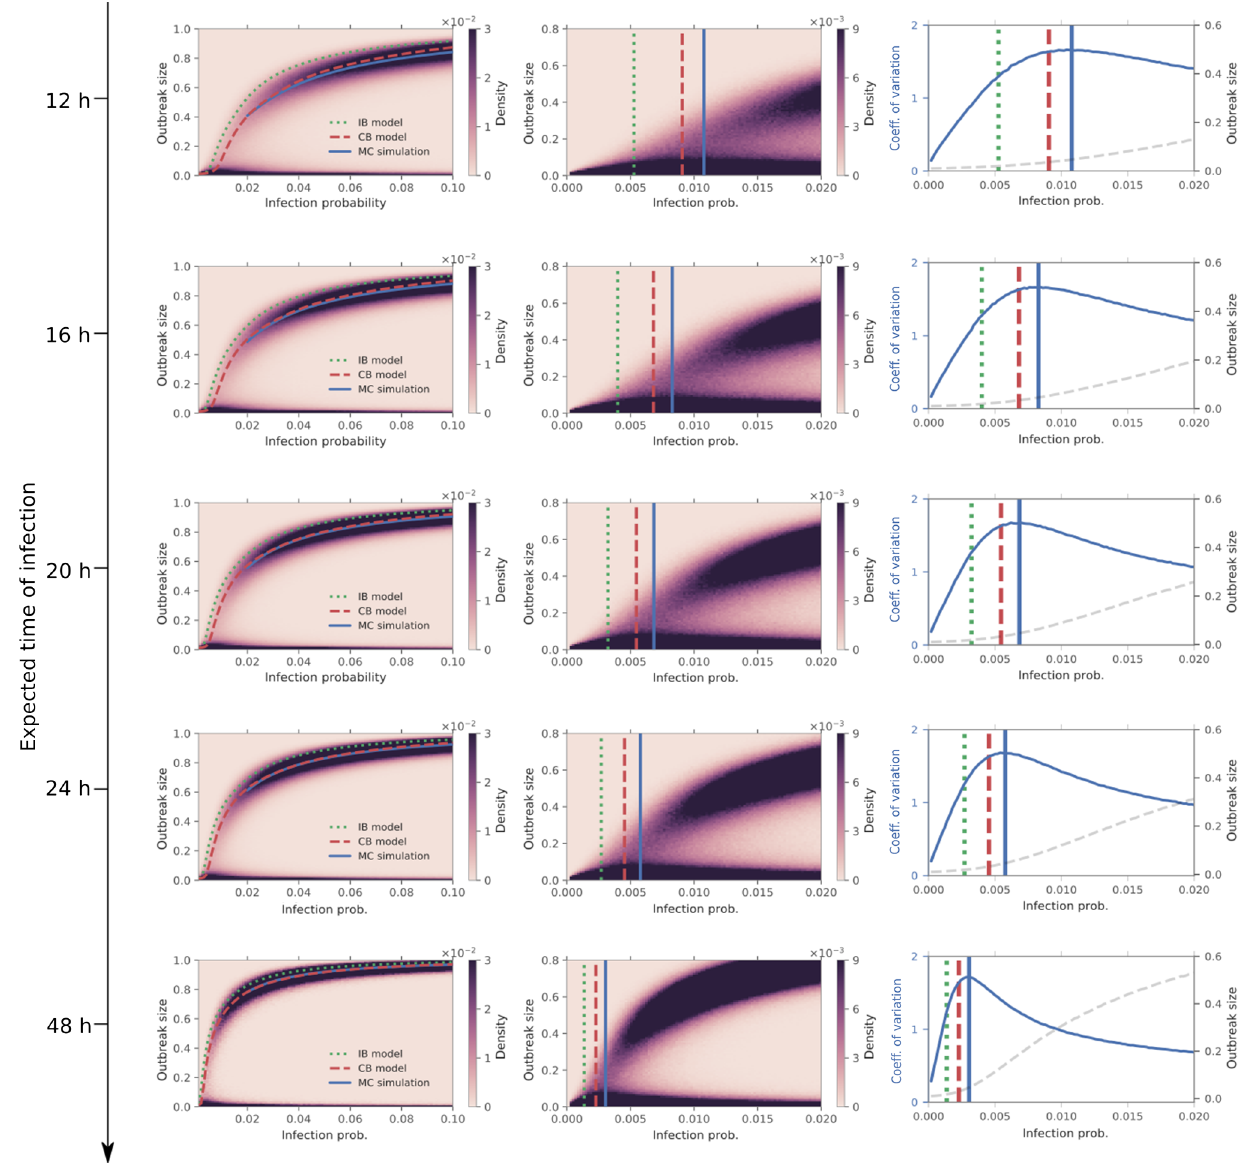
FIG. 18. Comparison between MC simulations and the mean-field models for different values of μ . Every row assumes a fixed recovery probability μ with decreasing values from top to bottom: μ ¼ 4 . 63 × 10 − 4 , μ ¼ 3 . 47 × 10 − 4 , μ ¼ 2 . 78 × 10 − 4 , μ ¼ 2 . 31 × 10 − 4 , and μ ¼ 1 . 16 × 10 − 4 . These values correspond to an expected infection period of 12, 16, 20, 24, and 48 h. The left column, middle column, and right column correspond to Figs. 4, 6(a), and 6(b), respectively, of the main